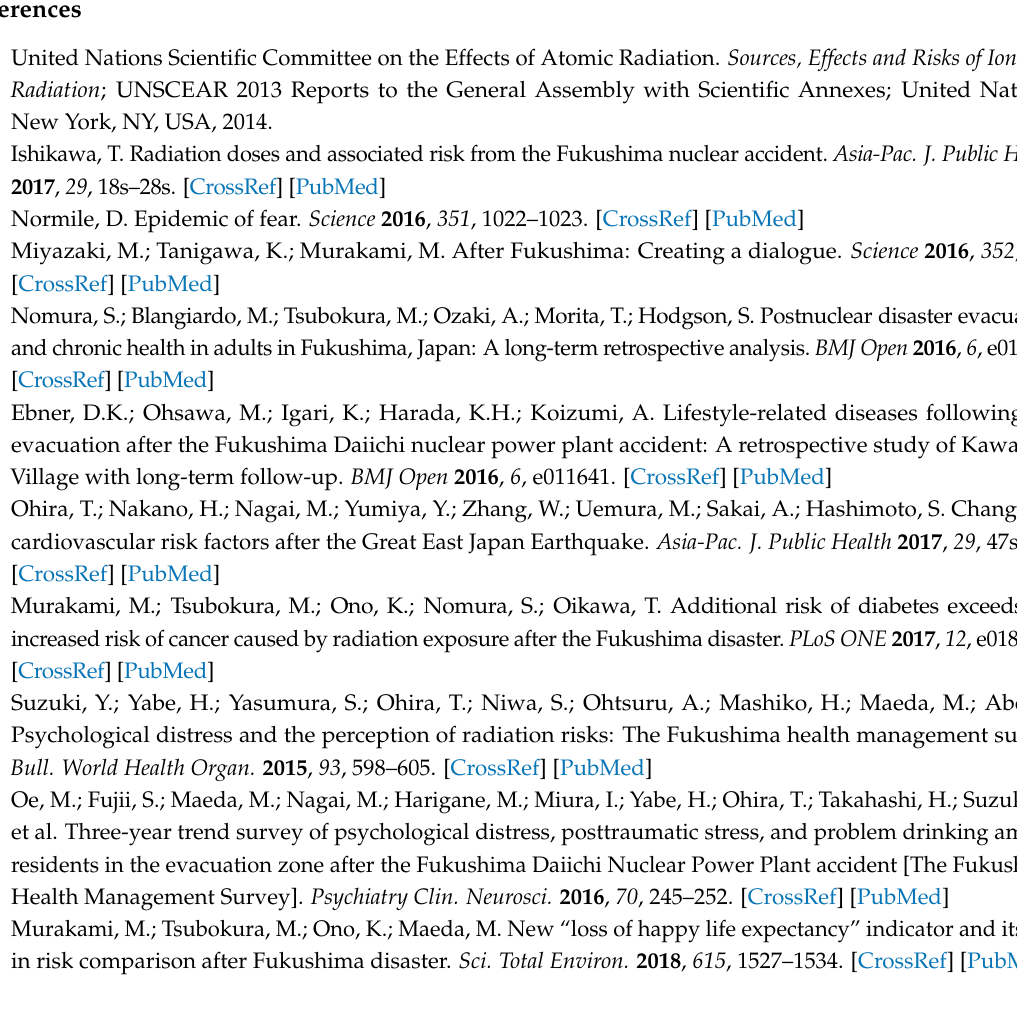
Figure S1: Differences in outcomes according to participation in/utilization of radiological countermeasures before propensity score matching; Table S1: Arithmetic mean, standard deviation (SD) and distributions of radiation risk perceptions; Table S2: Distributions of risk acceptance; Table S3: Distributions of evaluation for each radiological countermeasure; Table S4: Basic characteristics of respondents; Table S5: Distributions of each outcome; Table S6: Spearman’s correlation matrix among